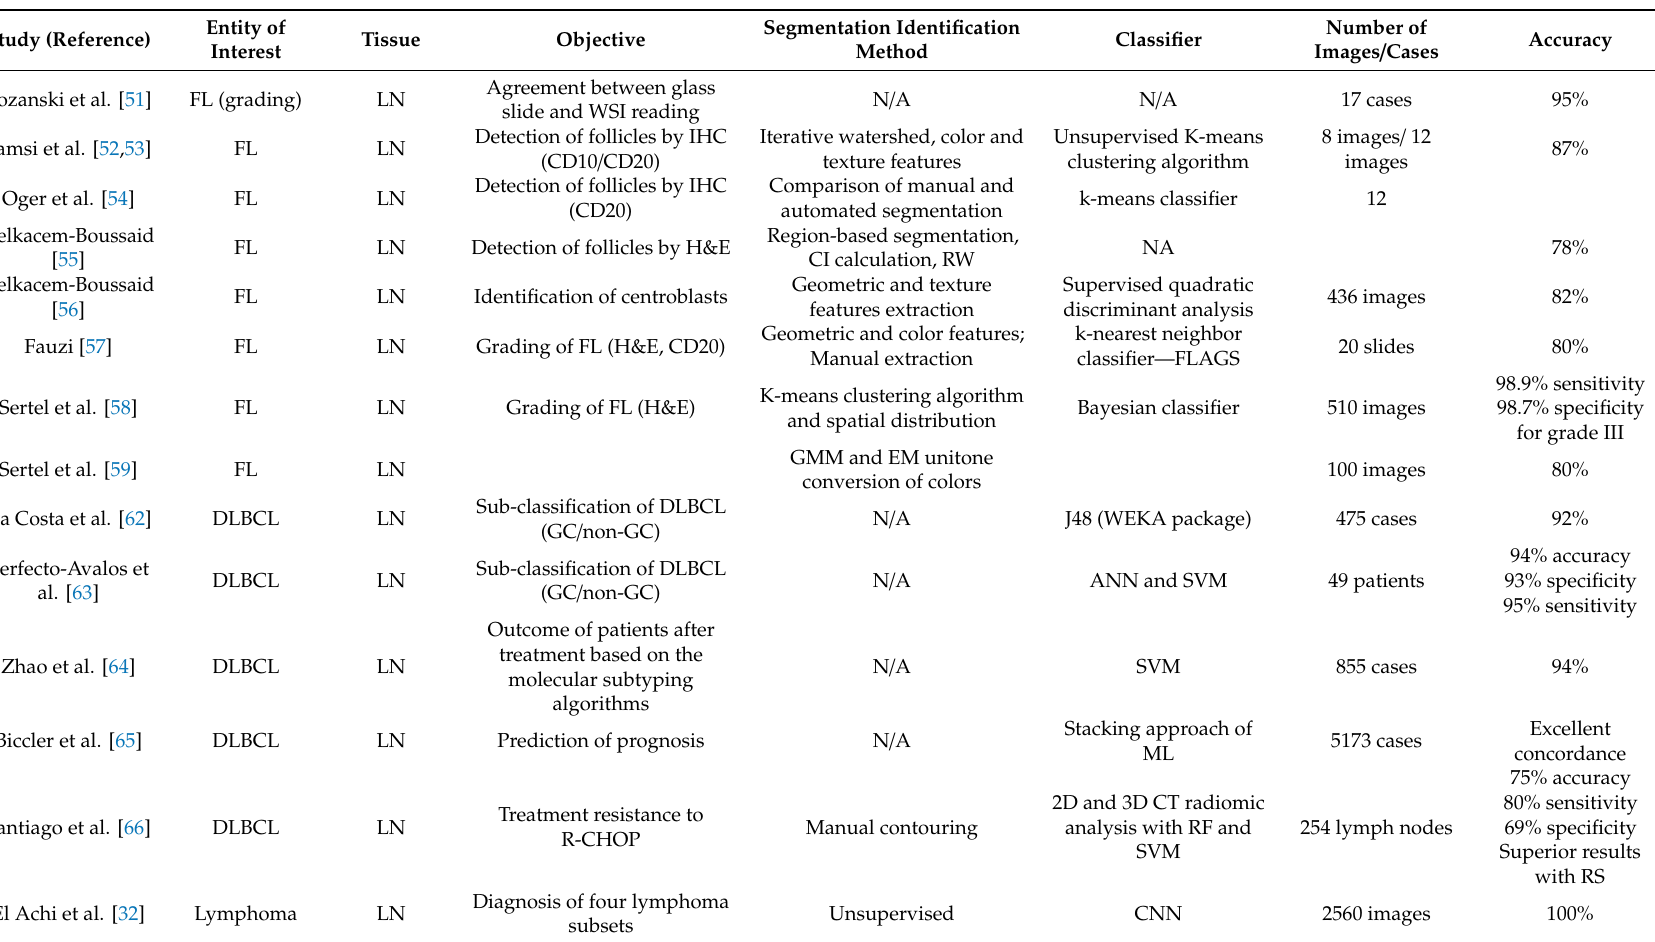
Table 2. Studies utilizing ML for mature lymphoproliferative diagnosis, grading, and prognostication. WSI, whole slide image; RW, recursive watershed; DLBCL, di ff use large B-cell lymphoma, LN, lymph node, FL, follicular lymphoma; H&E, hematoxylin and eosin; IHC, immunohistochemistry; CI, concavity index; FLAGS, Follicular Lymphoma Grading System; GMM, Gaussian mixture model; EM, expectation maximization; ANN, artificial neural networks; SVM, support vector machine; RF, random forests; CNN, convolutional neural